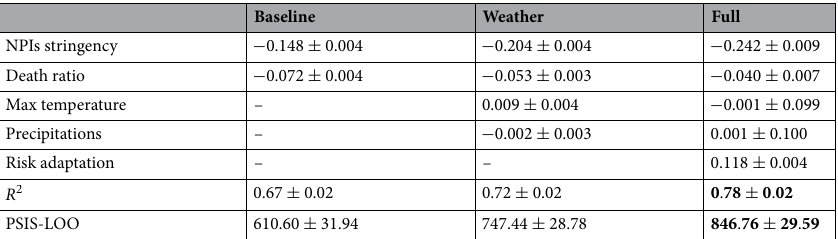
Table 1. Quantitative results of the Bayesian multivariate linear mixed model to explain the daily number of visits to POIs. We report the mean and 95% confidence intervals of all the β coefficients. We report the mean 2 and standard deviation for R and